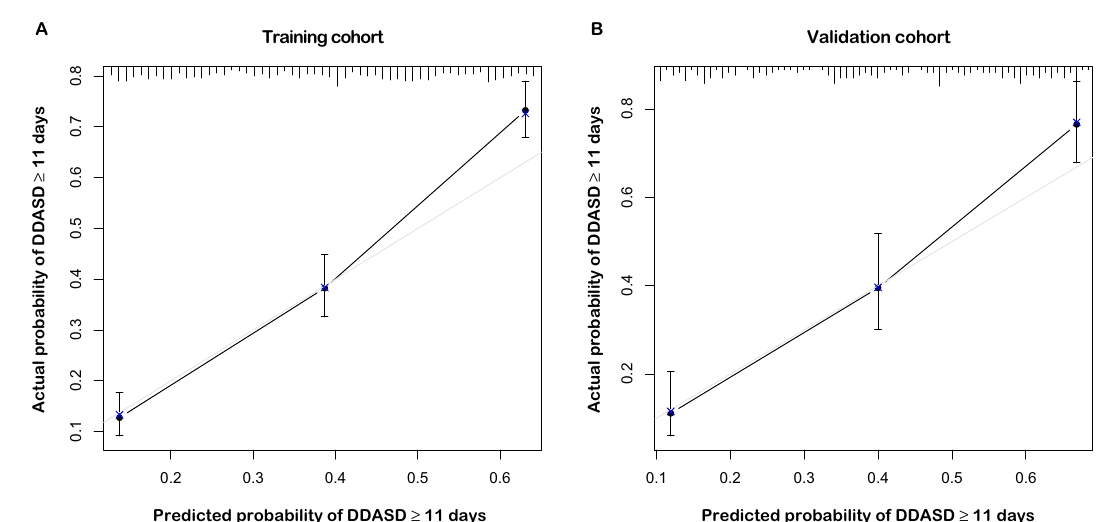
Figure 2. Calibration plots for checking the concordance between the nomogram ‐ predicted and actual probability of retaining the suction drain at the median DDASD in the ( A ) training cohort and ( B ) validation cohort. DDASD, drainage duration of axillary suction